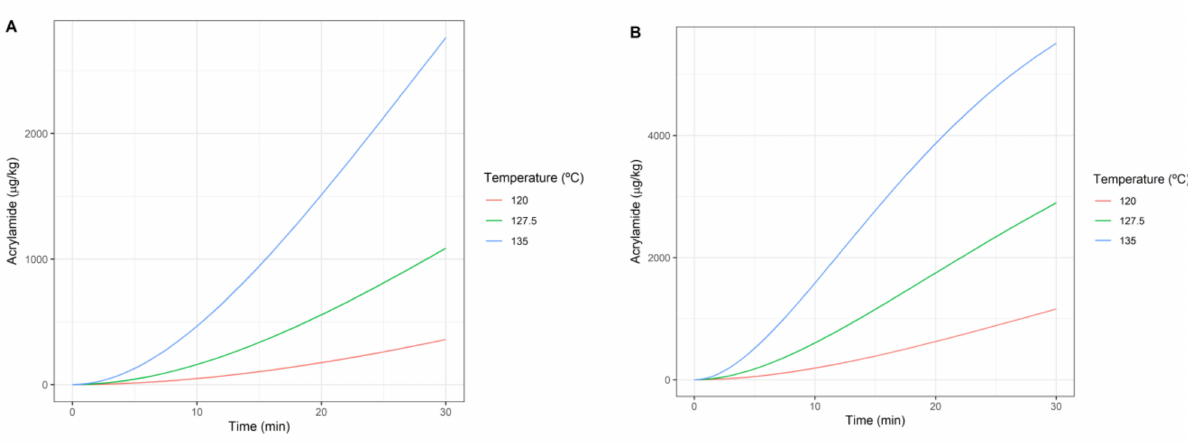
Figure 4. Acrylamide formation dynamics according to the Maillard reaction: potato puree ( A ) and prune juice ( B ). Figure 5A,B represent the inactivation curves for five different temperatures between 120 and 135 ◦ C and the acrylamide formed for each temperature when P ( log 10 S ≥ 6 ) = 0.95 for pureed potato and prune juice, respectively. Inactivation curves are represented as coloured lines and the left y-axis measures the number of logarithmic reductions. As discussed before, higher temperatures result in a higher slope of the inactivation rate. Bars placed at the times required for each treatment temperature show that processes at higher temperatures need less treatment time to achieve at least six log-reductions with a 95% probability. On the other hand, the height of each bar represents the acrylamide formed for each treatment (time–temperature).